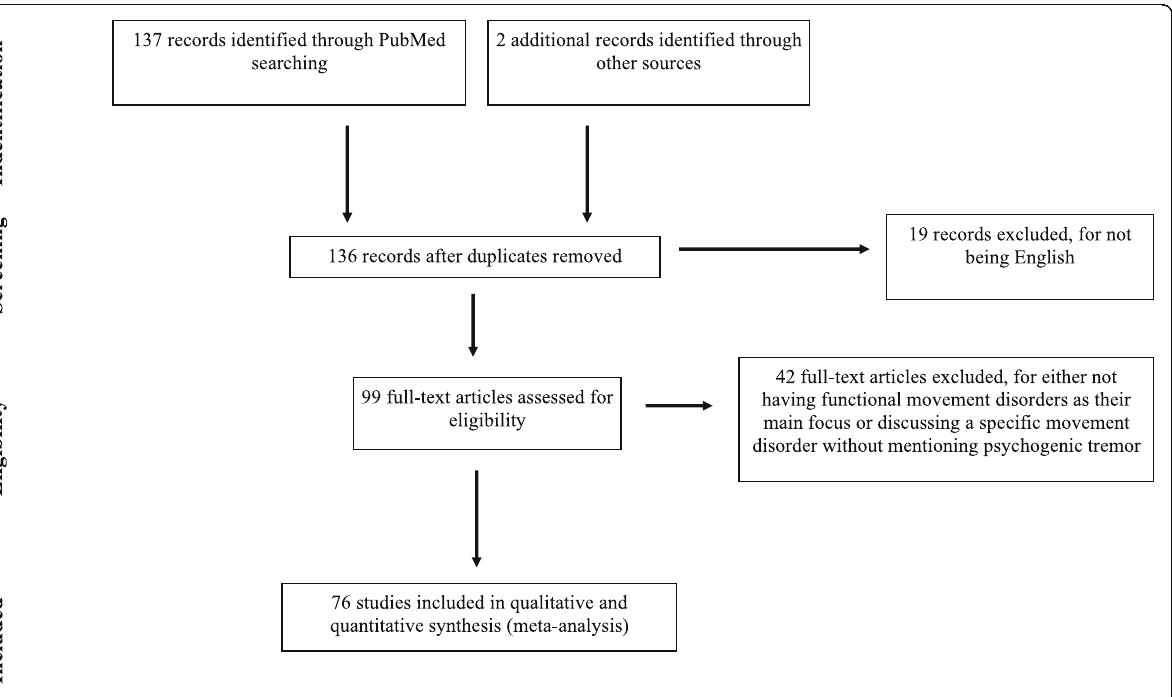
Fig. 1 flow of information, systematic